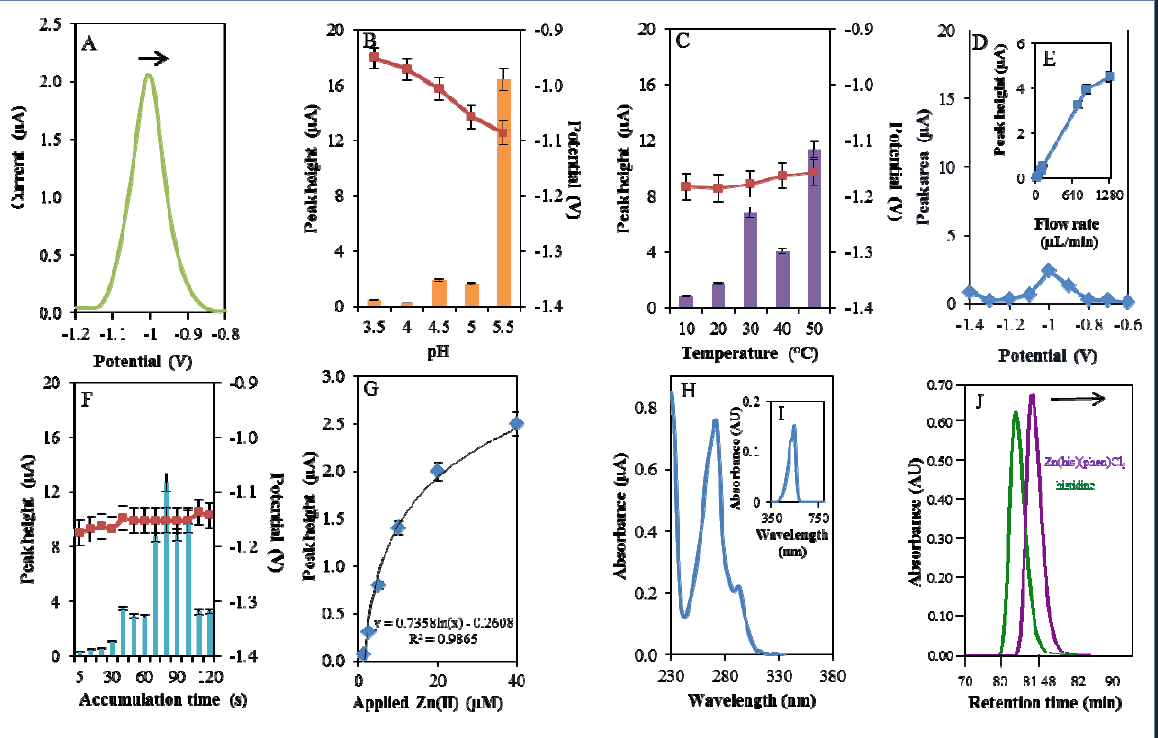
Figure 4. Electrochemical, spectrophotometric and chromatographic analysis of Zn(phen)(his)Cl complex. Basic parameters were 20 µM Zn(phen)(his)Cl in 0.2 M 2 2 acetate buffer, pH 5, temperature 20 °C unless stated otherwise. Electrochemical analysis of the Zn(phen)(his)Cl complex using DPV. A ) DP voltammogram of Zn(phen)(his)Cl . 2 2 influenced by Change in the height of reduction signal of Zn(phen)(his)Cl 2 ( B ) pH (3.5-5.5), ( C ) temperature (10–50 °C), ( D ) applied potential ( − 1.4– − 0.6 V), ( E ) applied flow rate (0-1,280 µL/min), ( F ) time of accumulation (5–120 s), and ( G ) Calibration curve of Zn (II) ions using DPV, dependence of used concentration of Zn(II) ions in the complex (1–40 µM) on the change of reduction signal. In Figures B , C , and F , the blue columns represent height of signals (peaks, left scale), red squares indicate the potential at which the height of signals was detected (right scale). Spectrophotometric and chromatographic analysis of the Zn(phen)(his)Cl complex. ( H ) Spectrophotometric 2 record of Zn(phen)(his)Cl measured within the range from 230 to 380 nm. ( I ) Detection of 2 Zn(II) ions using spectrophotometric record of the colored product of the reaction of Zn(phen)(his)Cl with 5-brom-PAPS with absorption maximum recorded at 550 nm. 2 ( J ) Chromatogram demonstrating dependence of absorbance of histidine and on retention Zn(phen)(his)Cl 2